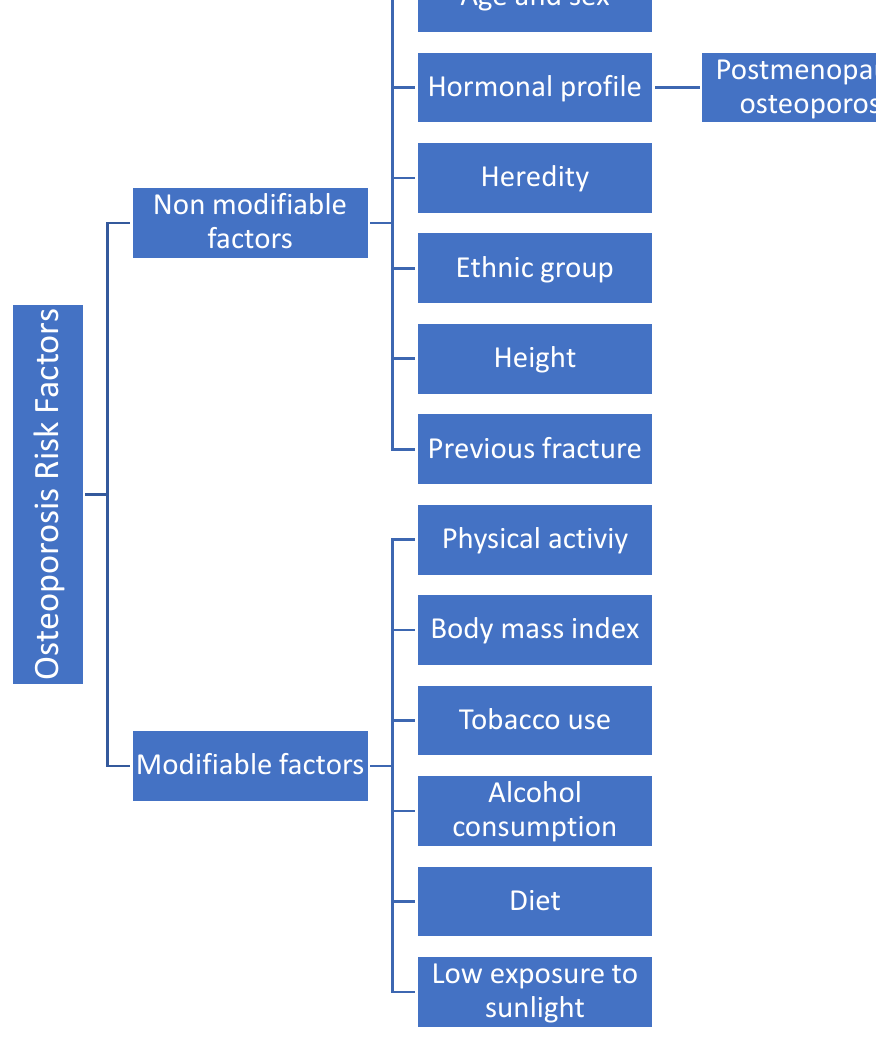
Figure 1. Risk factors for osteoporosis.